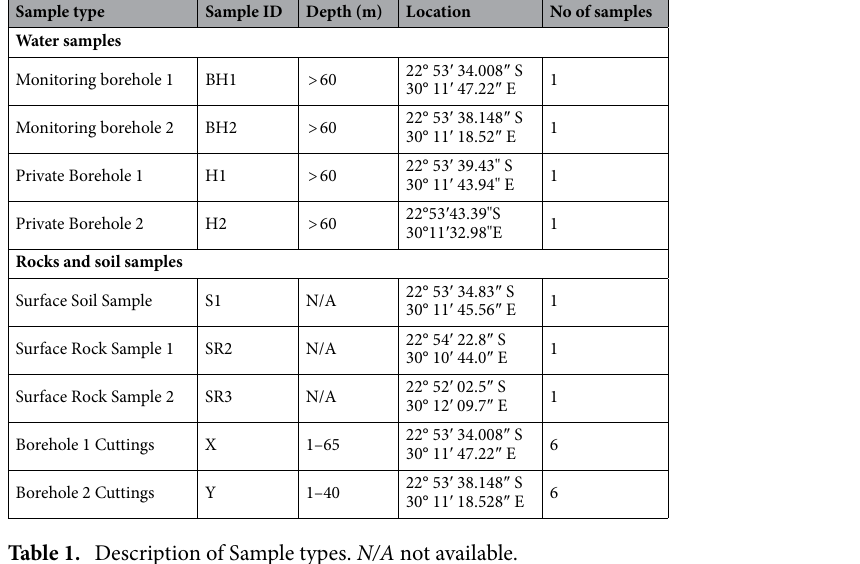
Table 1. Description of Sample types. N/A not